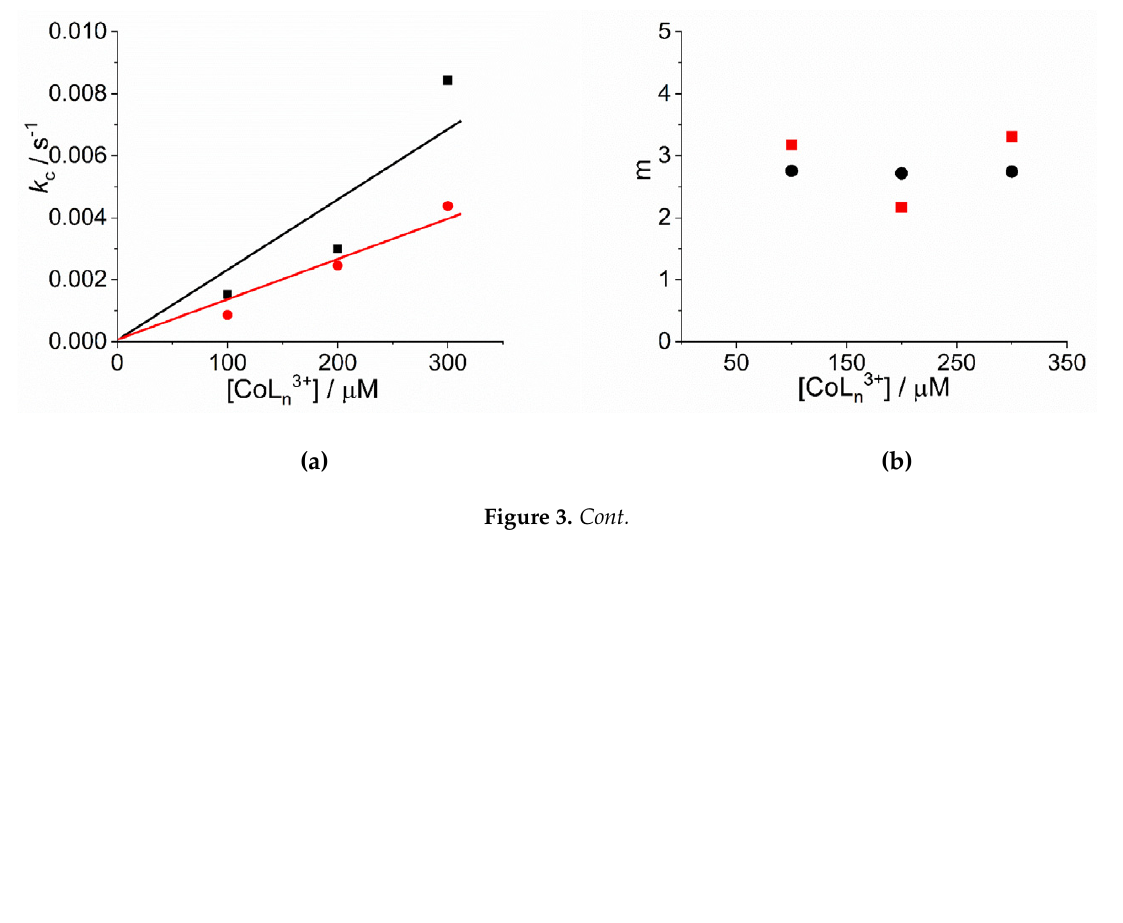
Table 1. Relevant kinetic parameters for the J-aggregation of H 2 TPPS 4 ( k 0 , k c , m and n ) as function of [CoL n3+ ] (pH = 2, T = 298 K).